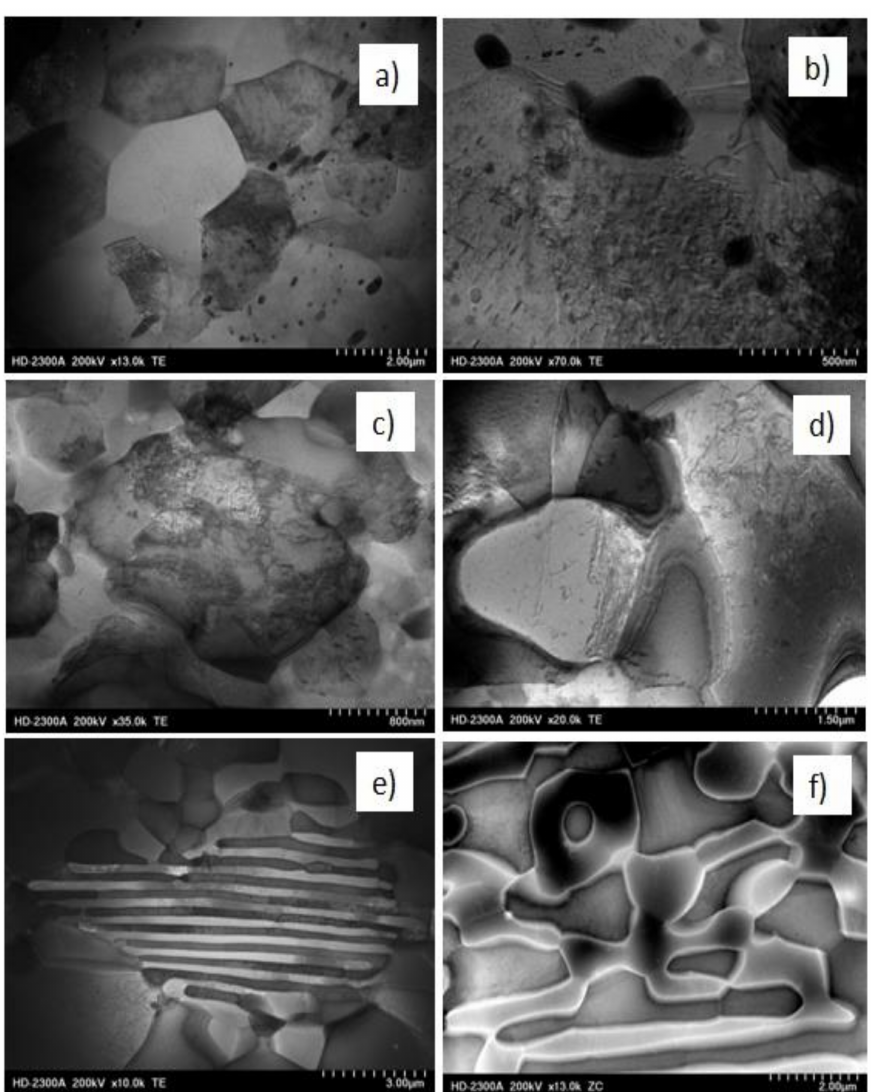
Figure 11. STEM images showing the characteristic microstructures of Al–Cu alloys after tensile test at 400 ◦ C. The microstructures on the left side represent ZC images, while the microstructures visible on the right side represent TE images. ( a , b ) Al 5 Cu alloy, ( c , d ) Al 25 Cu alloy, ( e , f ) Al 33 Cu